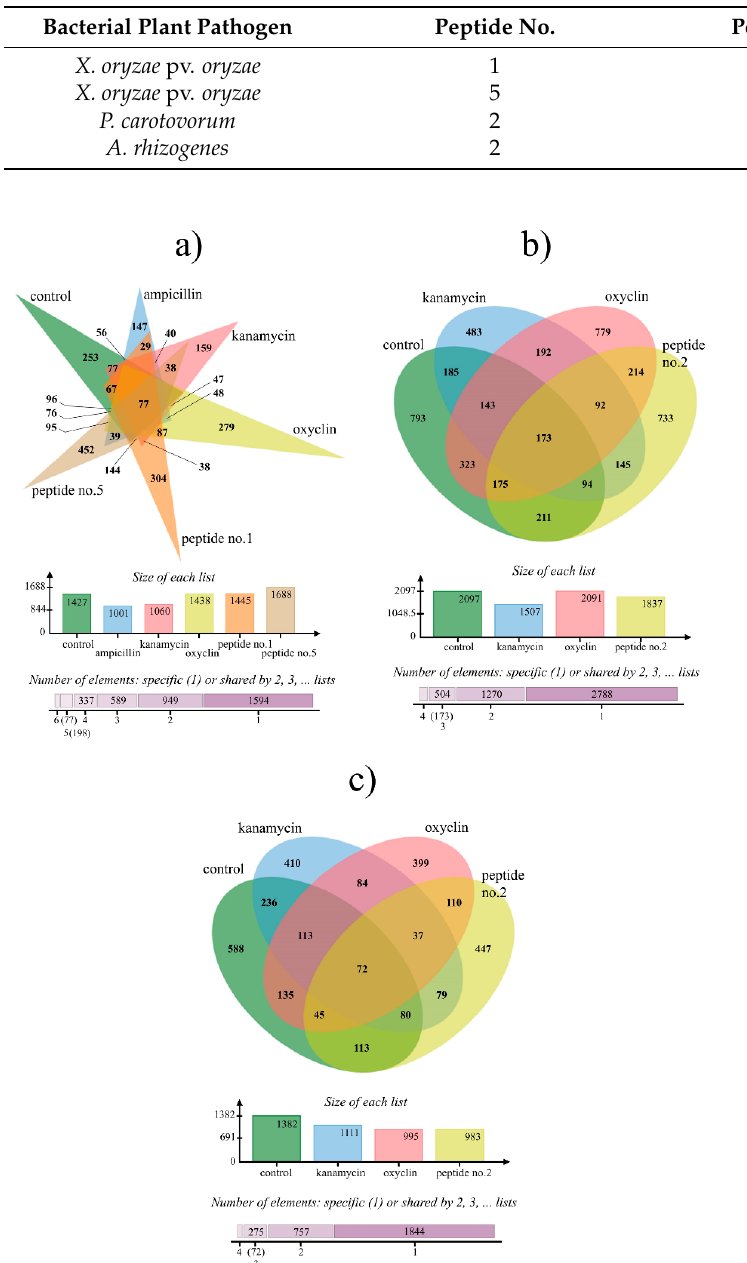
Figure 2. Venn diagram summary of protein expression in bacterial plant pathogens treated with selected peptides and antibiotics: ( a ) X. oryzae pv. oryzae , ( b ) Pectobacterium carotovorum, and ( c ) A. rhizogenes . The number of elements means the number of proteins detected in each treatment.